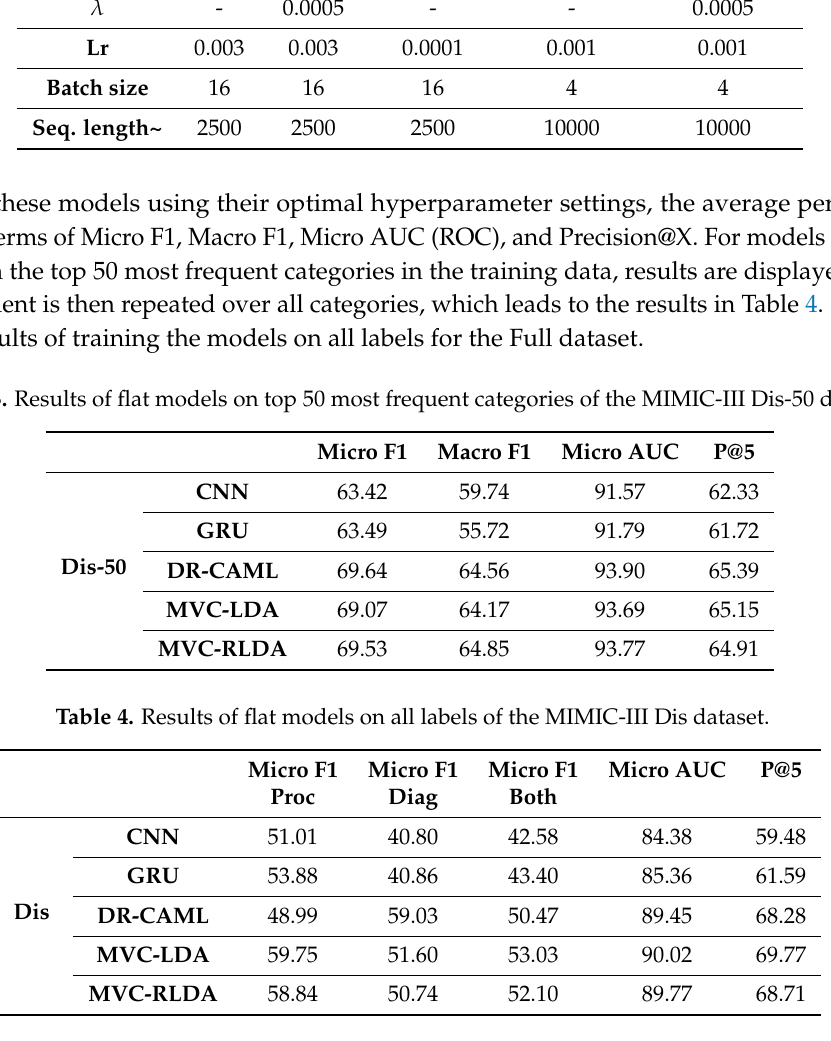
Table 5. Results of flat models on all labels of the MIMIC-III Full